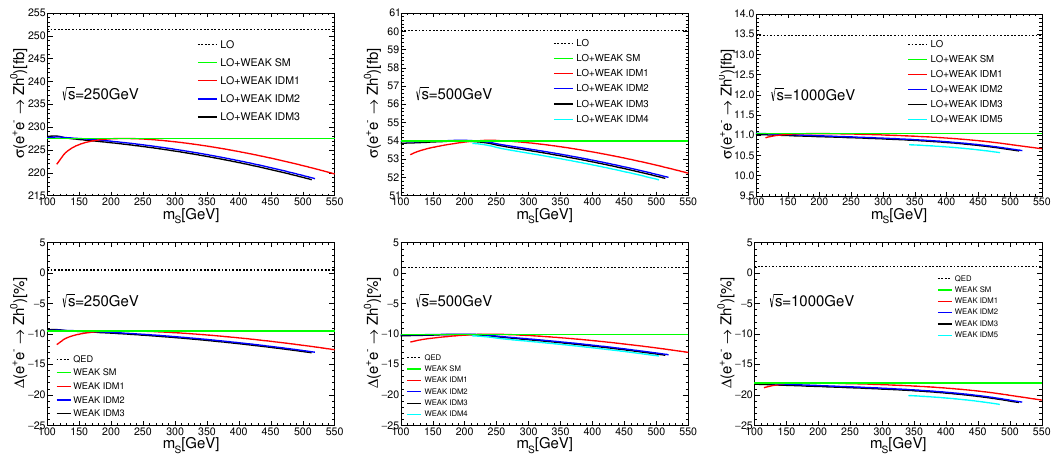
Figure 8 . In Scenario I, total cross section and relative corrections for e + e − → Zh 0 as a function of the Higgs masses m with three collision energies S sponding values of µ 2 are given in table 3. 2